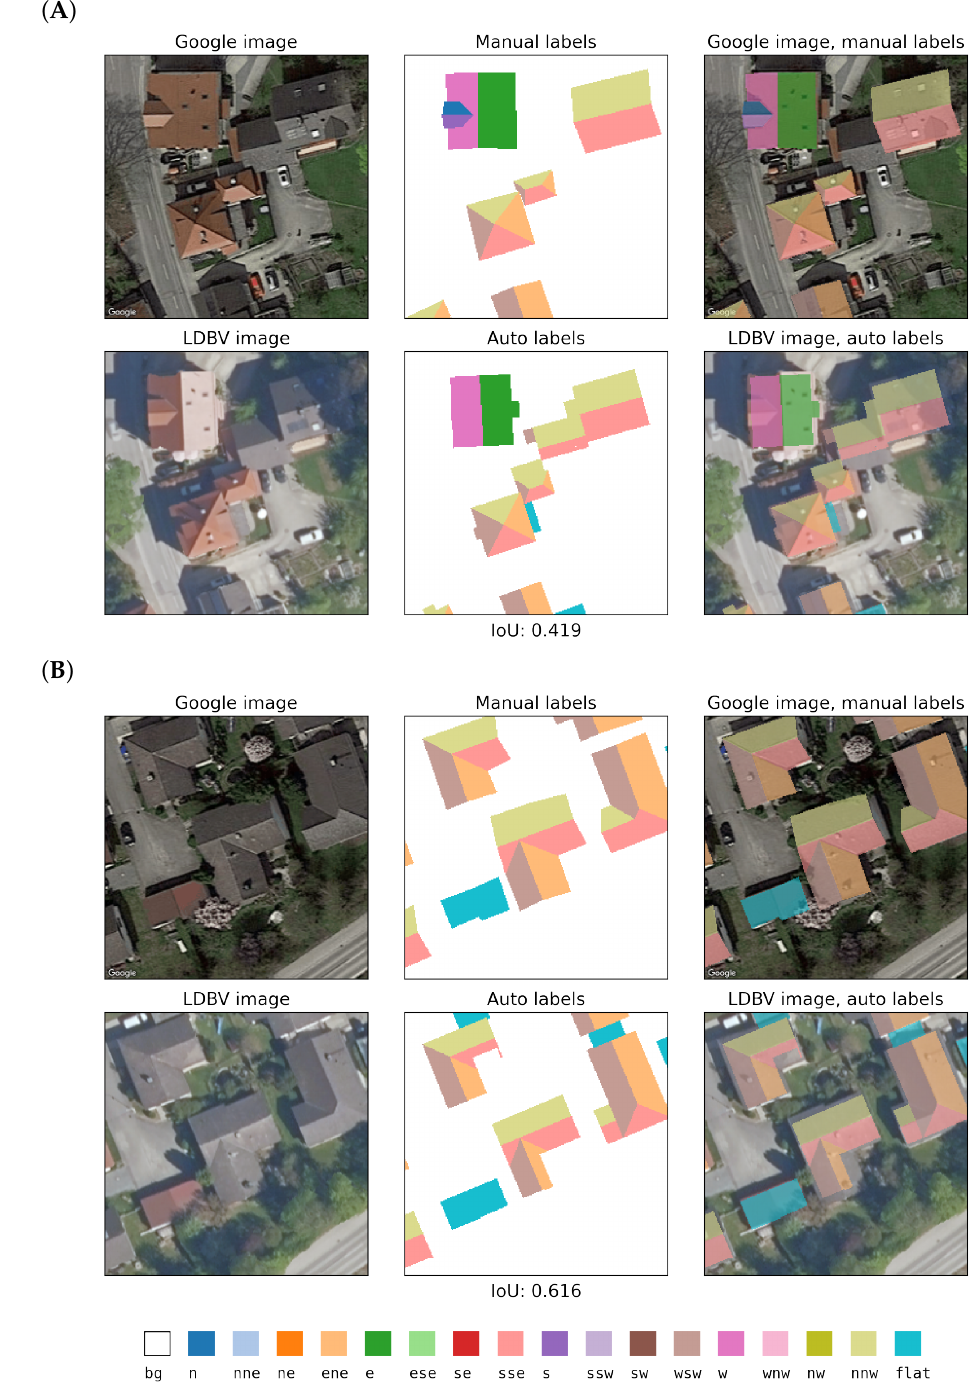
Figure 5. Exemplary comparison of manual and automatic samples from the small-scale datasets. IoU is given. ( A ) Manual labels identify dormer, auto labels do not; on the other hand, auto labels identify segments missing in manual dataset. ( B ) Auto labels do not cover roof overhangs and sometimes wrongly represent roof geometry, as for the cross-gabled building to the